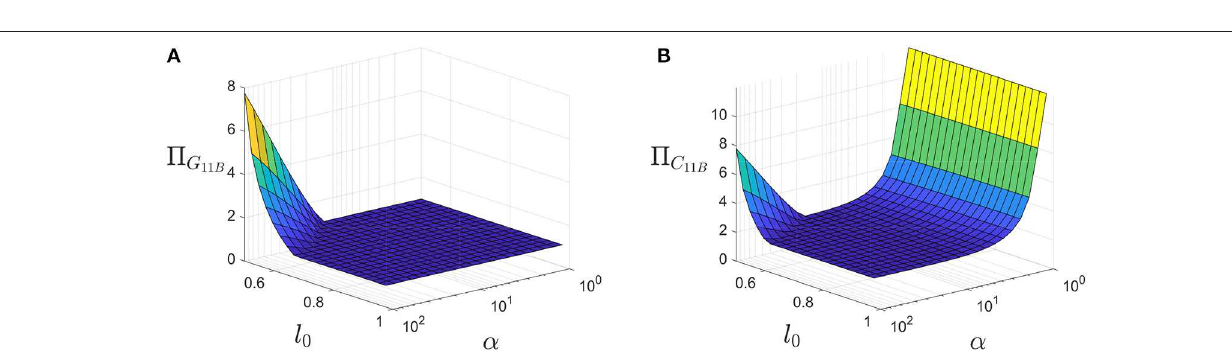
FIGURE 12 | Exploration of transition behavior of the geometric energy of the hexagonal system (A) and total energy (B) as a function of α and l 0